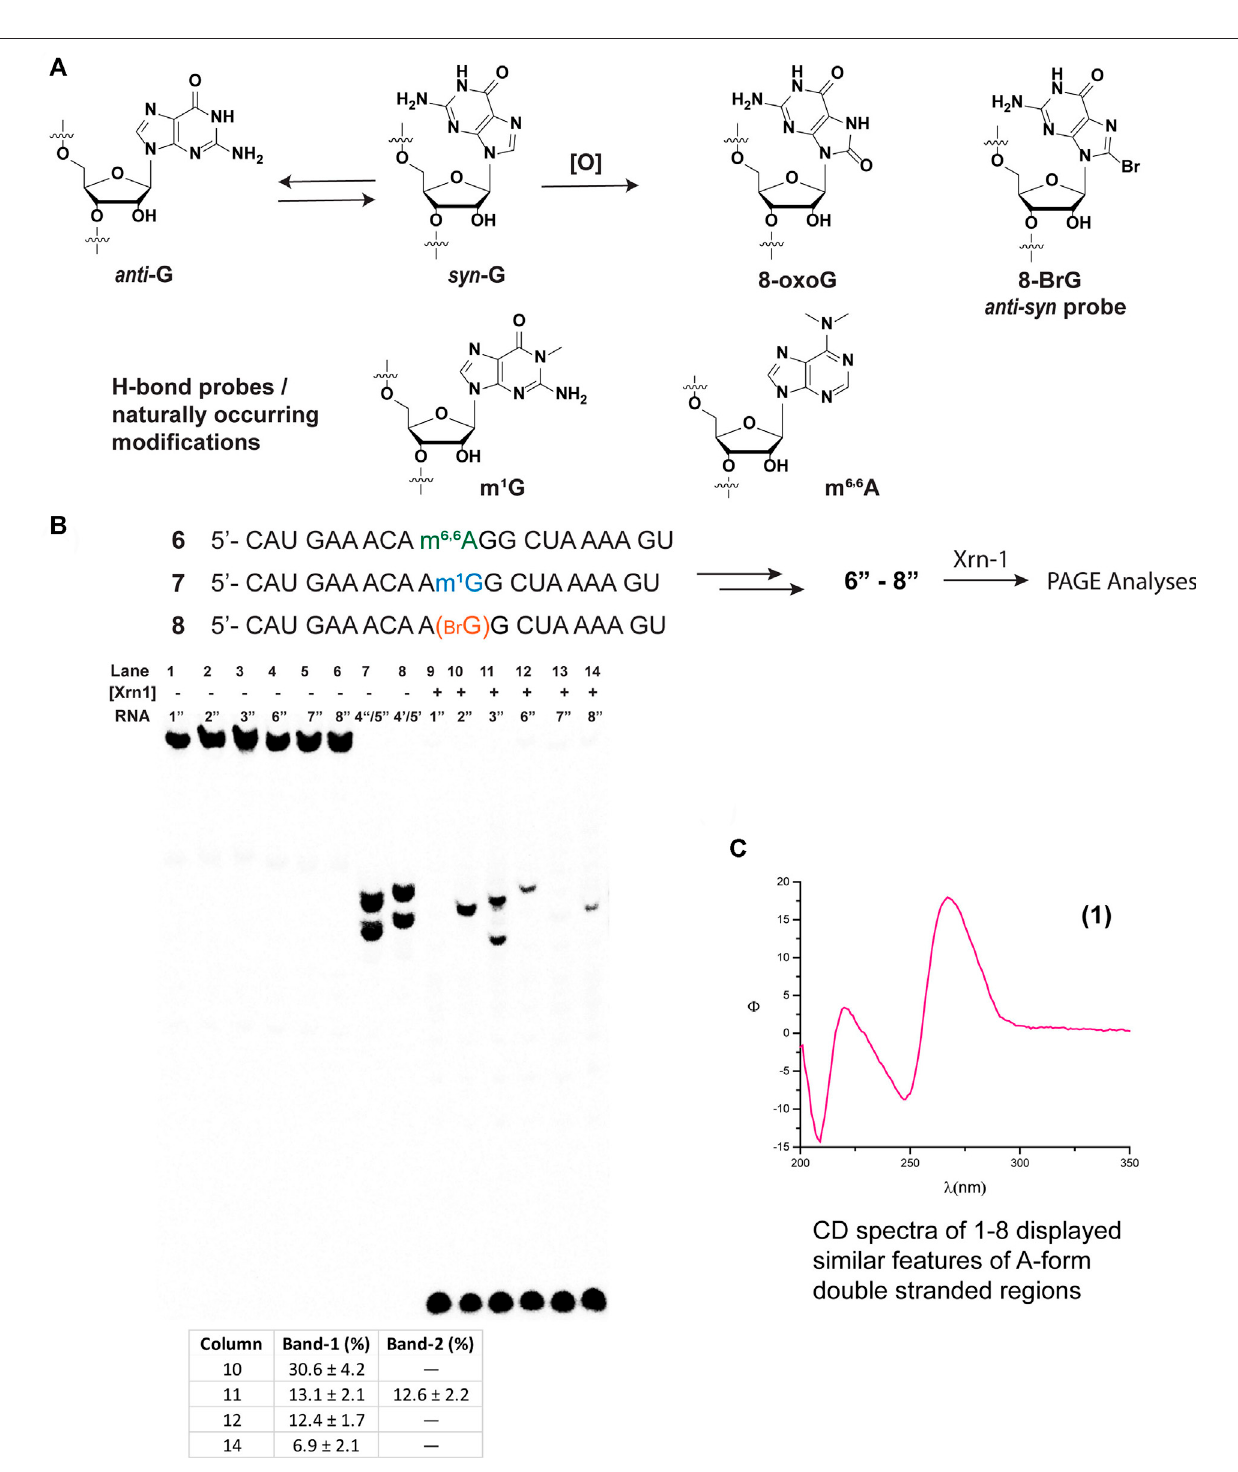
FIGURE 2 | Structure and conformational changes of G and functionalized G/A with methyl groups (to probe H-bonding), or with bromine to probe for anti-syn conformational changes (A) ; and their incorporation onto sequences 6 – 8 for their corresponding reactivity with xrn-1 and analyses via PAGE (B) . (C) displays the CD spectrum of RNA 1 in a buffered solution (4 μ M RNA, 100 mM NaCl, 5 mM MgCl 2 , 10 mM sodium phosphate, pH 7.5).